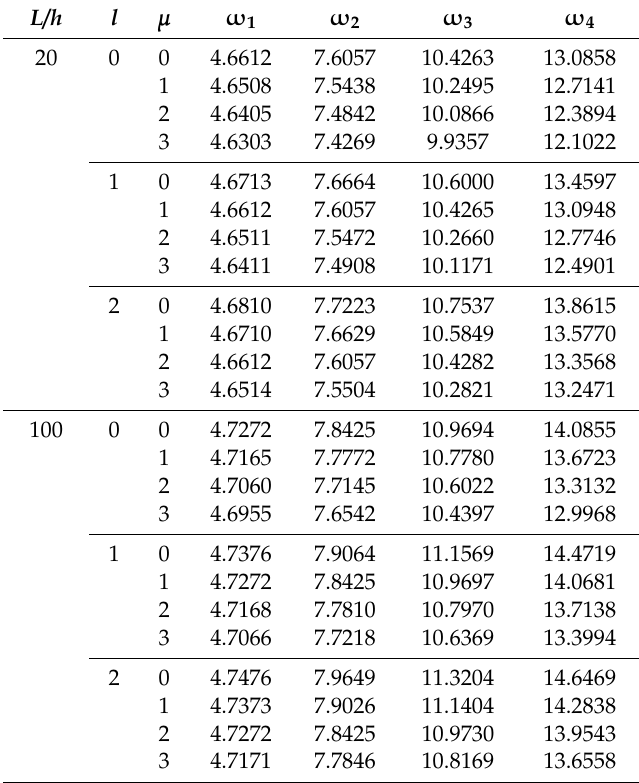
Table 6. E ff ect of the L / h and small-scale parameters on the natural frequencies for a clamped-clamped triclinic